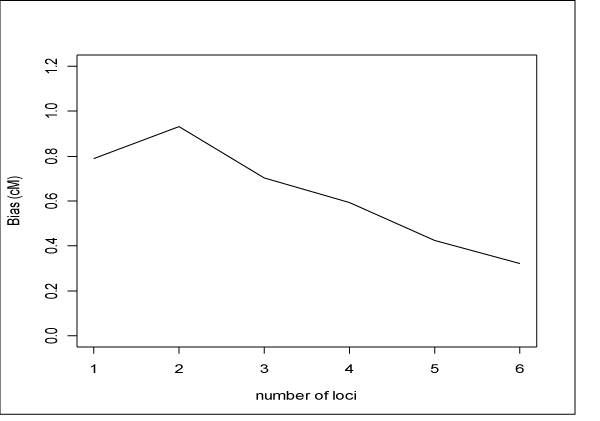
Bias in disease locus localization. Average distance to disease locus of average (over region) of significant (Bonferroni-corrected) loci.